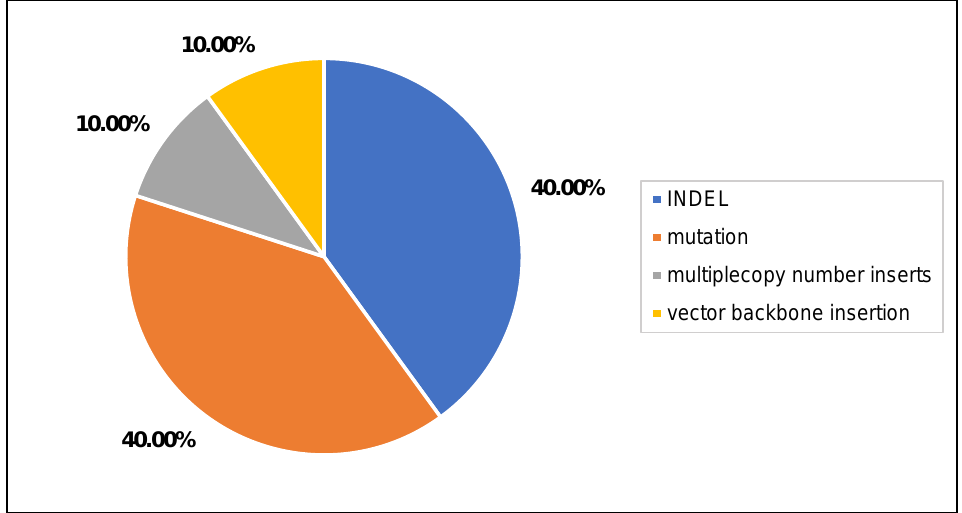
Figure 7. Genomic outcomes from CRISPR-Cas9 via biolistic bombardment. N = 2 articles. Colors in graph correspond to legend in Figure 4A.